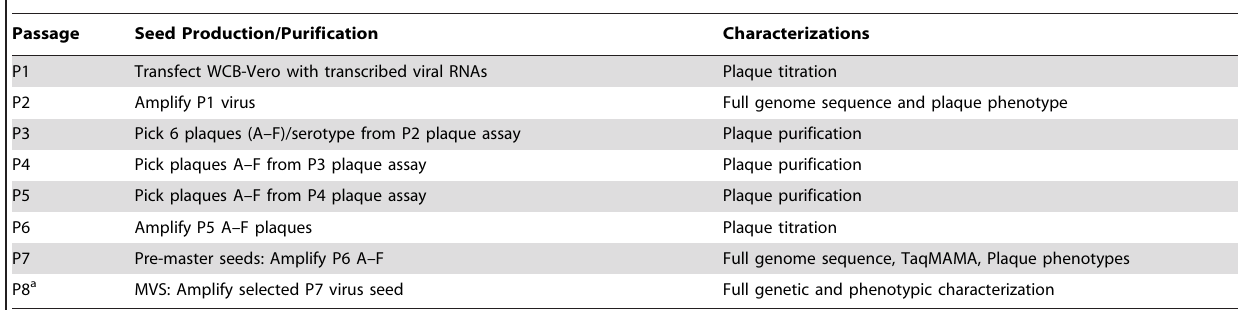
Table 1. cGMP Rederivation of DENVax MVS in WCB-Vero